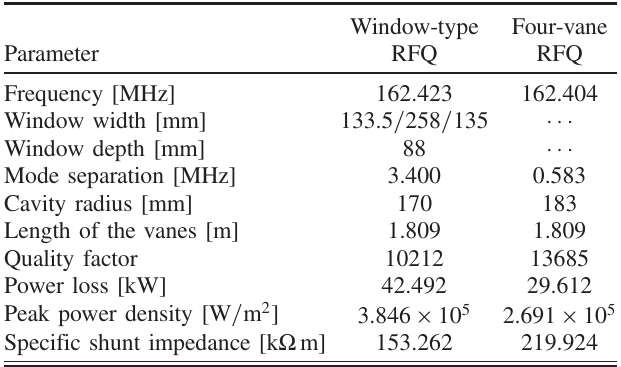
TABLE IV. Comparison of a window-type RFQ and a normal four-vane RFQ.